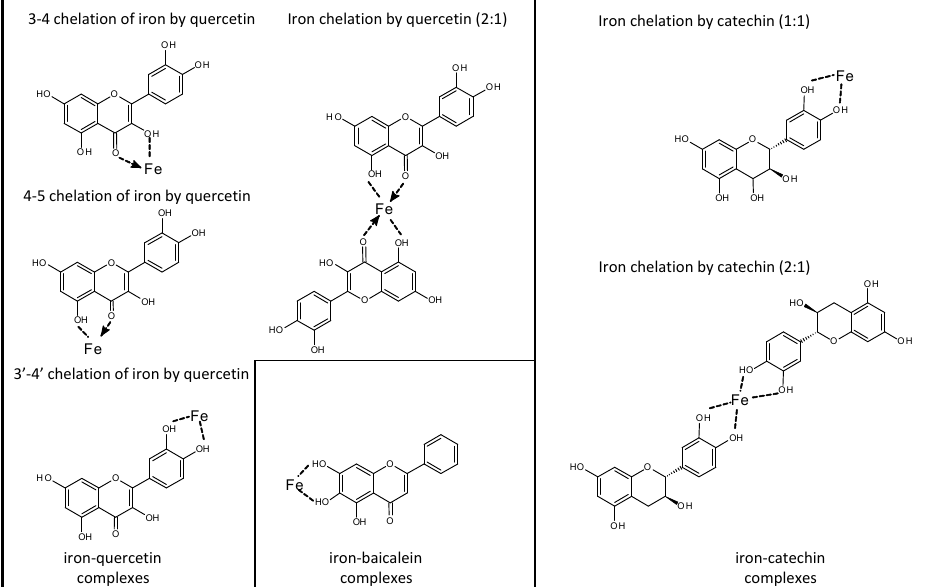
Figure 1. The proposed structures of iron complexes with various flavonoids based on [158,160,161]. Among potent inhibitors of iron absorption are various teas which are rich in cate- chins. Hurrel et al. [162] demonstrated that drinking beverages that contain 20–50 mg total polyphenols per serving caused a reduction in Fe absorption from a bread meal by 50–70% (compared to drinking water), whereas beverages containing 100–400 mg total polyphenols/serving reduced Fe absorption by 60–90%. The most potent inhibitors of Fe absorption were black teas (79–94%), peppermint tea (84%), pennyroyal (73%), and cocoa (71%), and the inhibition was reduced in a dose-dependent fashion depending on the content of total